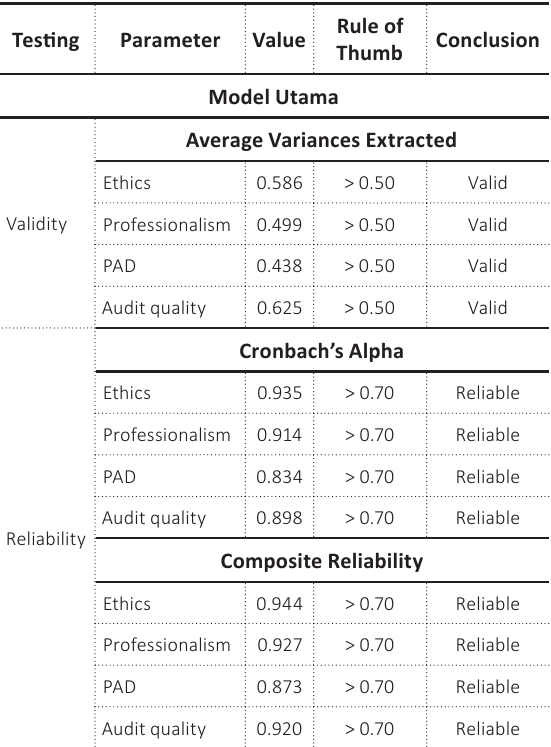
Table 1. Descriptive statistics